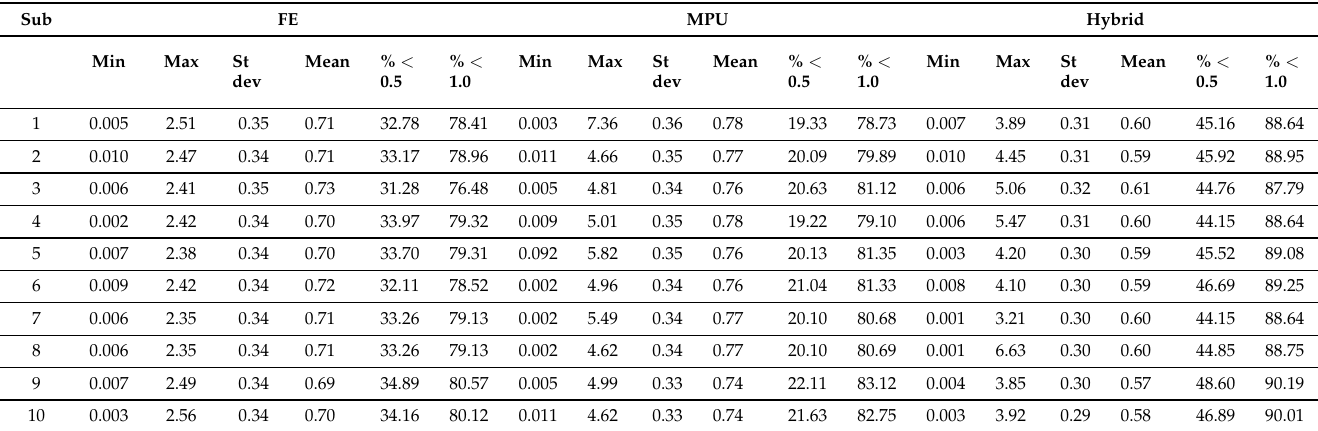
Table 3. Approximation quality of reconstructed surfaces for 10 brain cortices. Metrics are calculated in units of voxels (mm).